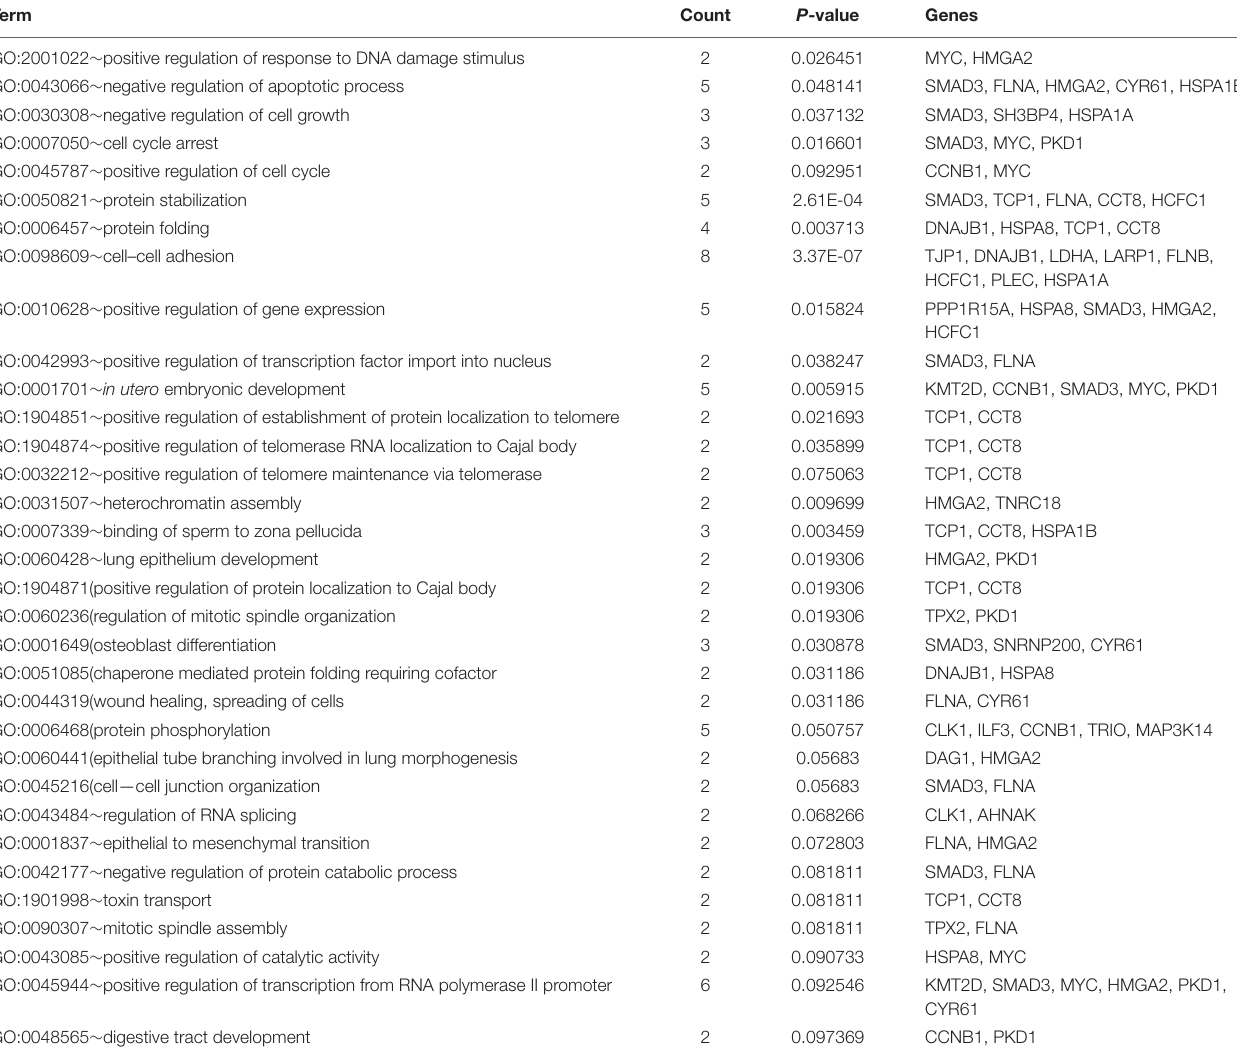
TABLE 3 | Gene ontology enrichment analysis on SKOV3 and COV434 common deregulated genes. Term Count P -value